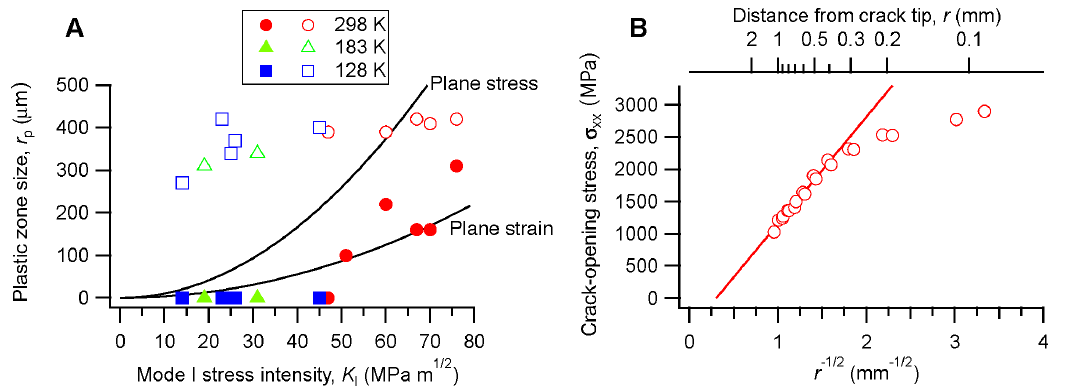
Figure 7. Plastic zones around crack tips. (a) The size of the plastic zone r p as determined in two ways: Solid symbols are from the radius of gyration R g of the region for which the von Mises effective stress has achieved its plateau value (Eqn. 3), while open symbols are from r { 1 = 2 fits similar to those in part (b). The uncertainty in the plastic zone size is approximately + 100 m m but for clarity error bars are not shown. For comparison, analytical estimates of r p are shown for plane stress and plane strain conditions (Eqn. 4) using a room-temperature yield stress of s ys ~ 1750 MPa . (b) Crack-opening normal stress s xx ahead of the crack tip for a specimen loaded to K I ~ 76MPam 1 = 2 at 298 K. The straight line is a fit to the data for r w 0 : 5mm